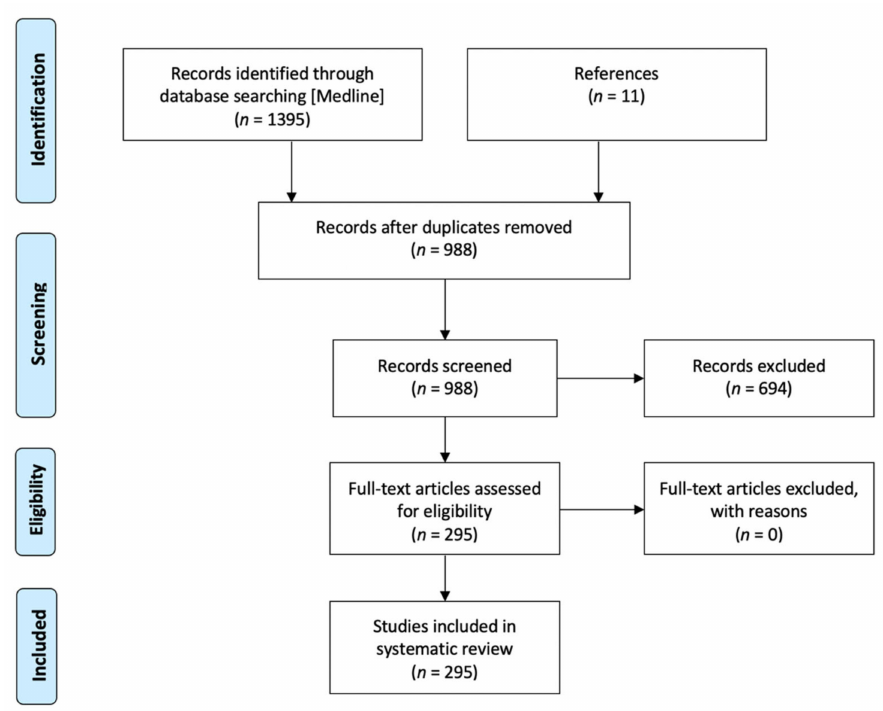
Figure 1. Flow chart of the inclusion process based on the “PRISMA 2009 flow diagram”.